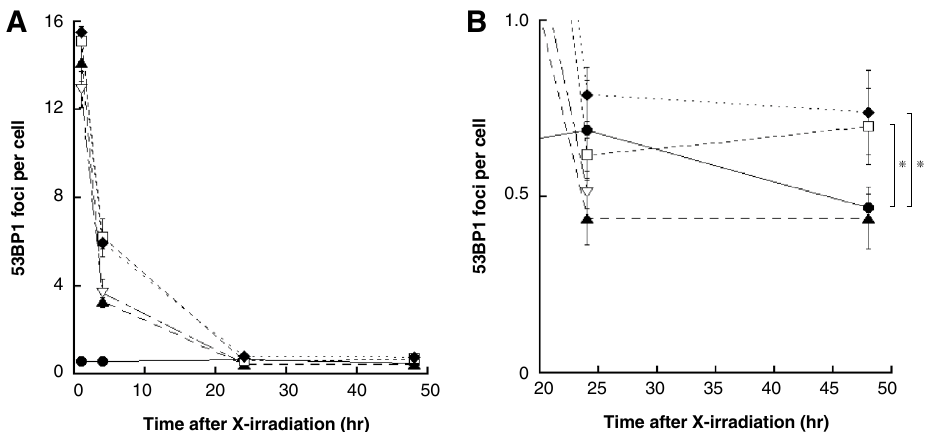
Figure 3. DSB repair curves for each X-irradiated field size. ( A ) The DSB repair curves were created by combining A-D in Fig. 2. The results were represented as mean ± standard error. Lower triangle, Triangle, Square, and Rhombus indicates the number 53BP1 foci per cell of X-irradiated cells in 0.02 mm 2 , 0.09 mm 2 , 0.81 mm 2 , and 1.89 mm 2 , respectively. The number of 53BP1 foci per cell in sham-irradiated controls is Closed circle. ( B ) The DSB repair curves focused on 24- to 48-h after X-irradiation. At 1.89 mm 2 and 0.81 mm 2 , the number of 53BP1 foci were significantly higher than background level at 48 h after X-irradiation (p < 0.05, t-test). These figures were created with KaleidaGraph